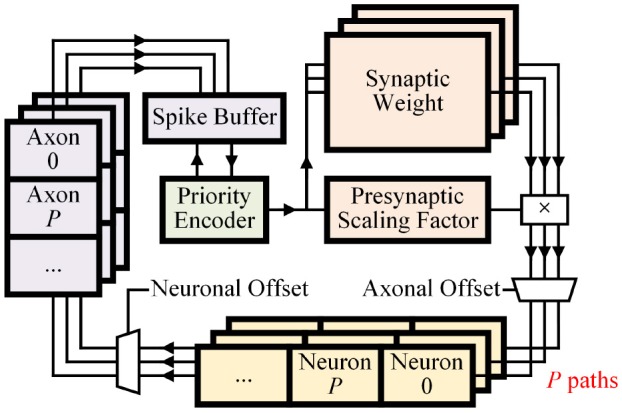
Dataflow of the design with parallelization number P. Learner module is omitted for simplicity.